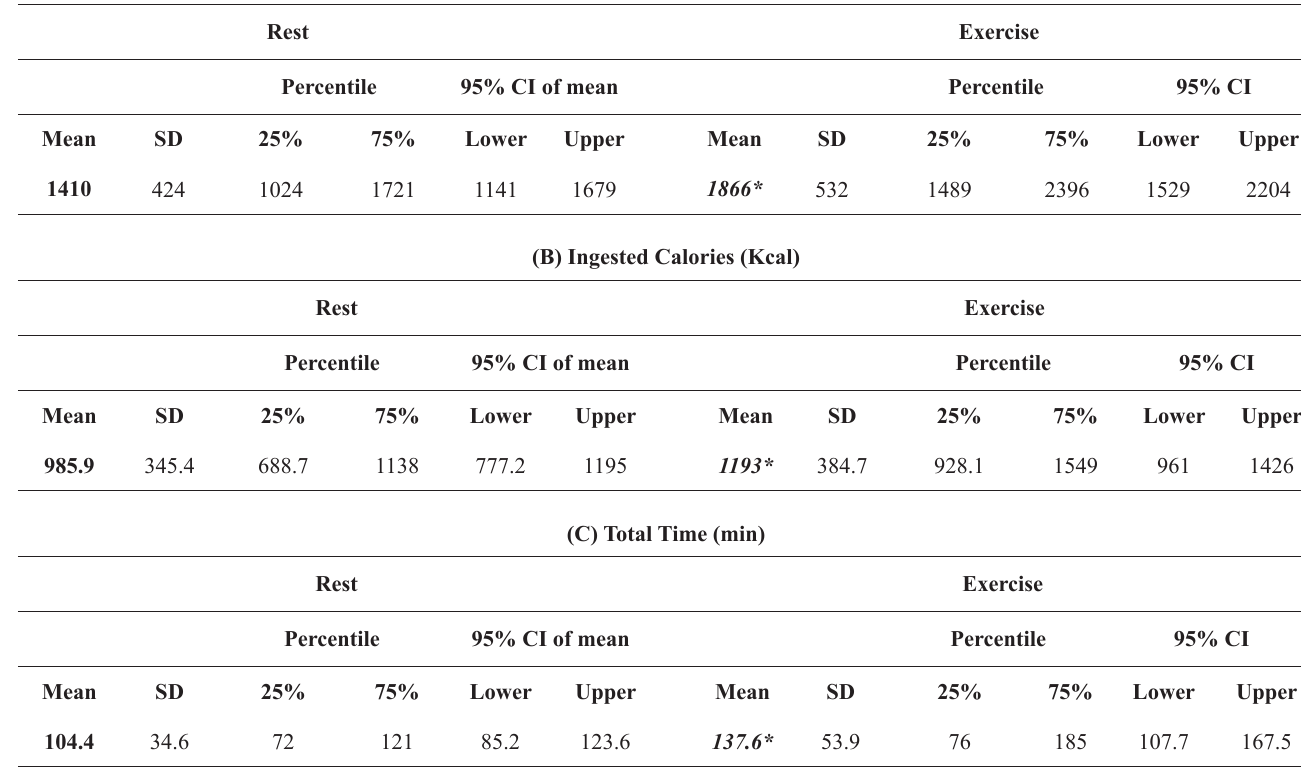
Table 1- A. Mean values of total intake (ml), Table 2-B, Ingested calories (Kcal) and Table 2-C, Time (minutes) at rest (day 0), or after exercise (day 14) during the drink test. Data are expressed as mean ± SD, Percentile (25% and 75%), and 95% CI (lower and upper). Statistical values were computed by the Student t-test for paired data. * p <0.05 vs. rest.